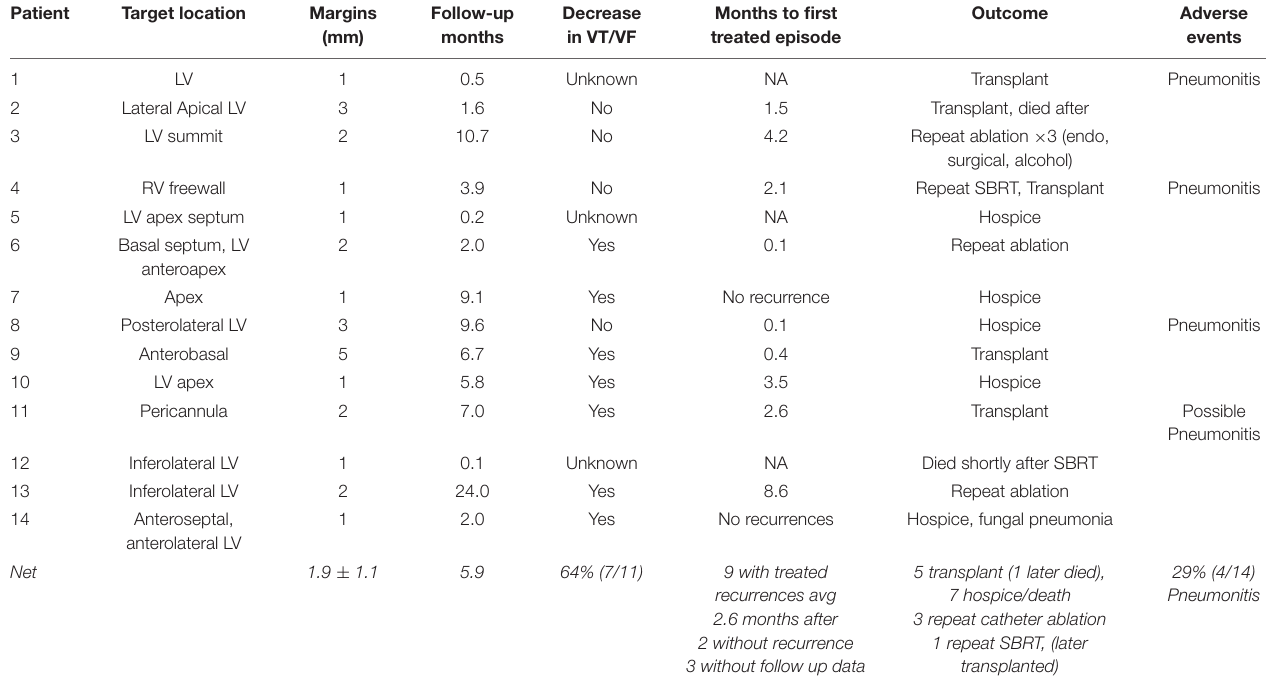
TABLE 2 | SBRT treatment and